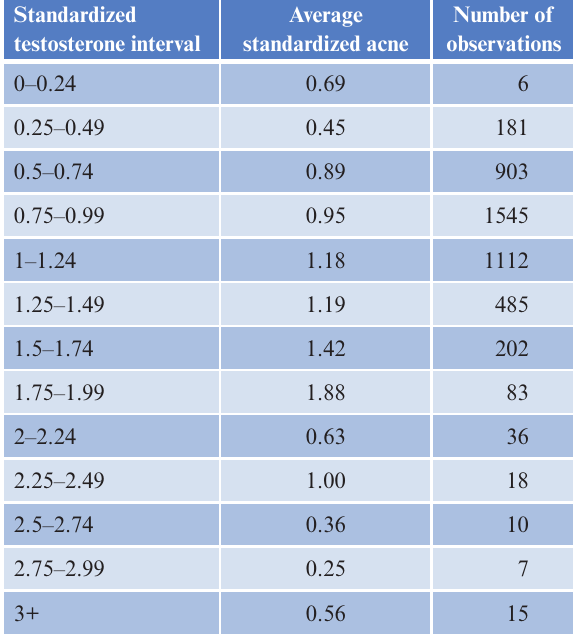
Table 1. Intervals of standardized testosterone and the corresponding average standardized acne